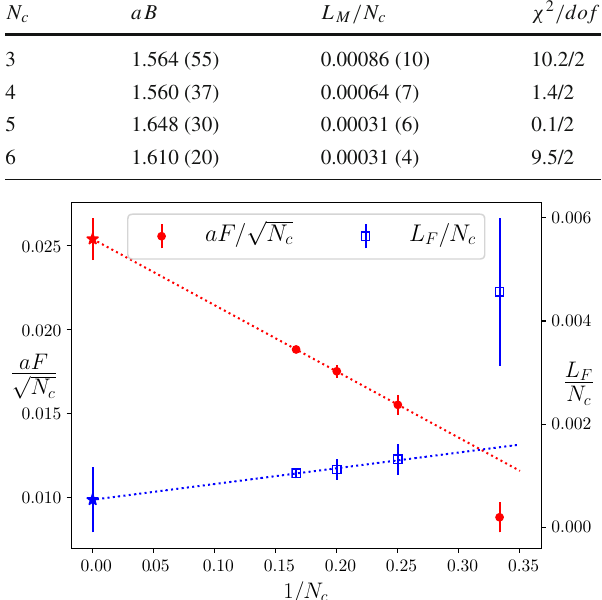
Table 5 Fits for M π for separate values of N c